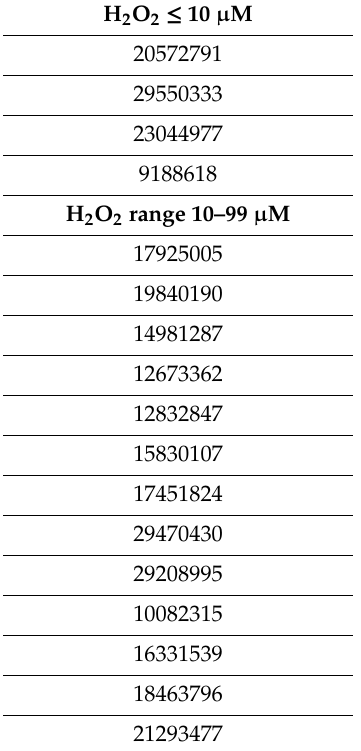
Table A1. The list hereafter indicates the PMID identifiers of the articles